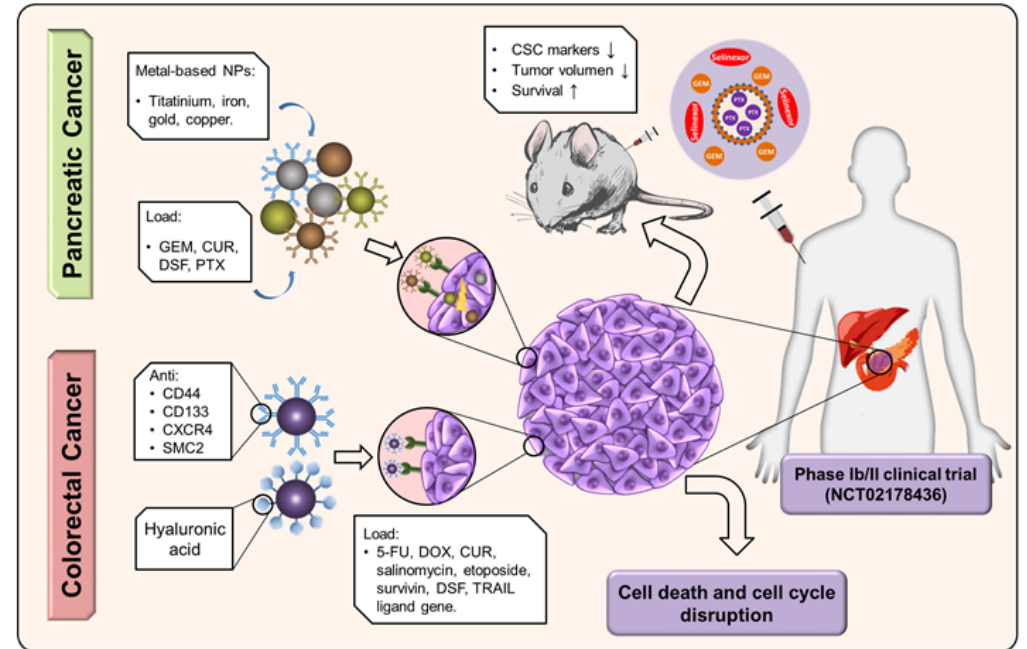
Figure 4. Main nanoplatforms used to overcome drug resistance in colon and pancreatic CSCs. While the CRC tends to use approaches with active targeting NPs to improve the entry of drugs, the PC opts for the use of metal-based NPs that are actively targeted or not.